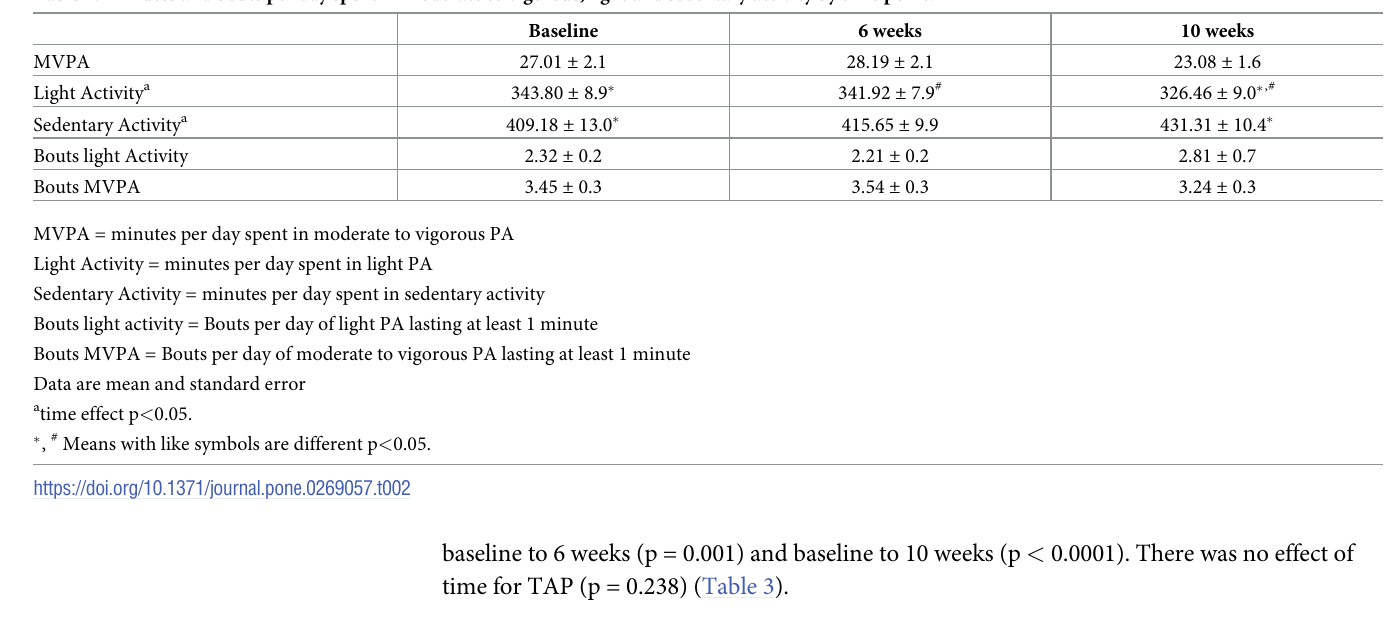
Table 2. Minutes and bouts per day spent in moderate to vigorous, light and sedentary activity by time point.